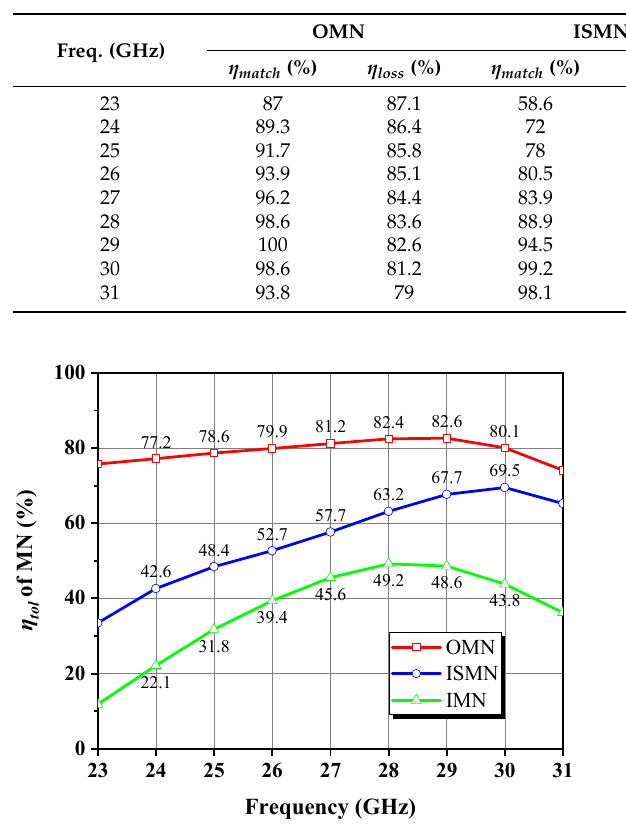
Figure 19. η tol of each MN across 23–31 GHz.